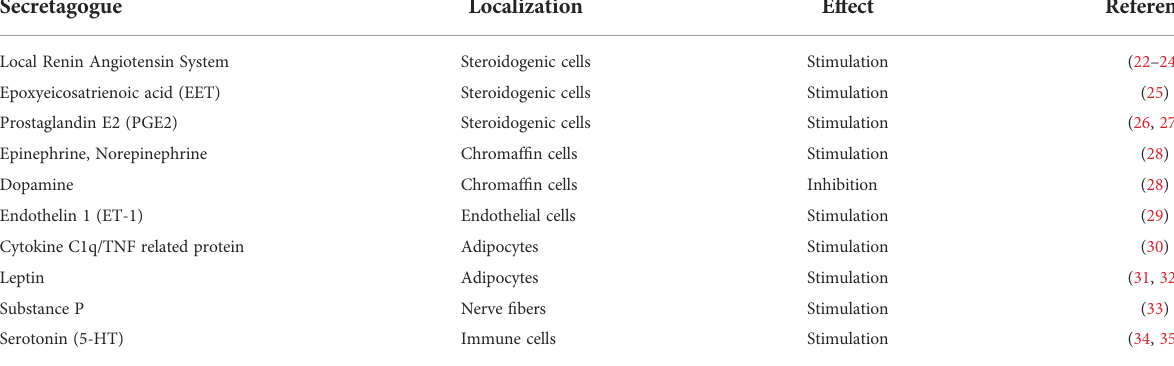
TABLE 1 Endocrine, paracrine and autocrine regulators of aldosterone biosynthesis. Secretagogue